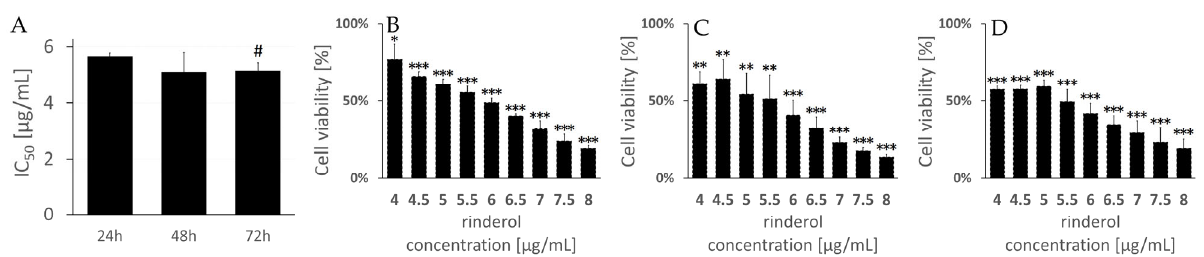
Figure 9. Rinderol cytotoxicity against HeLa cervical cancer cells after 24, 48, and 72 h of incubation obtained in MTT assay. ( A ) Summarized results of IC 50 for investigated incubation periods with rinderol. Grid (#) indicates a statistically significant difference compared to IC 50 value for 24 h incubation period ( p ≤ 0.05). ( B – D ) Dose-response curves of HeLa cells exposed to rinderol for 24 h ( B ), 48 h ( C ), and 72 h ( D ), expressed as % of control cells. Presented data are the means ± SD of three independent replicates. Asterisks (*) indicate statistically significant difference between respective rinderol concentration and control cells (exposed to solvent control) set as 100% viability (* p ≤ 0.05, ** p ≤ 0.01, *** p ≤ 0.001).